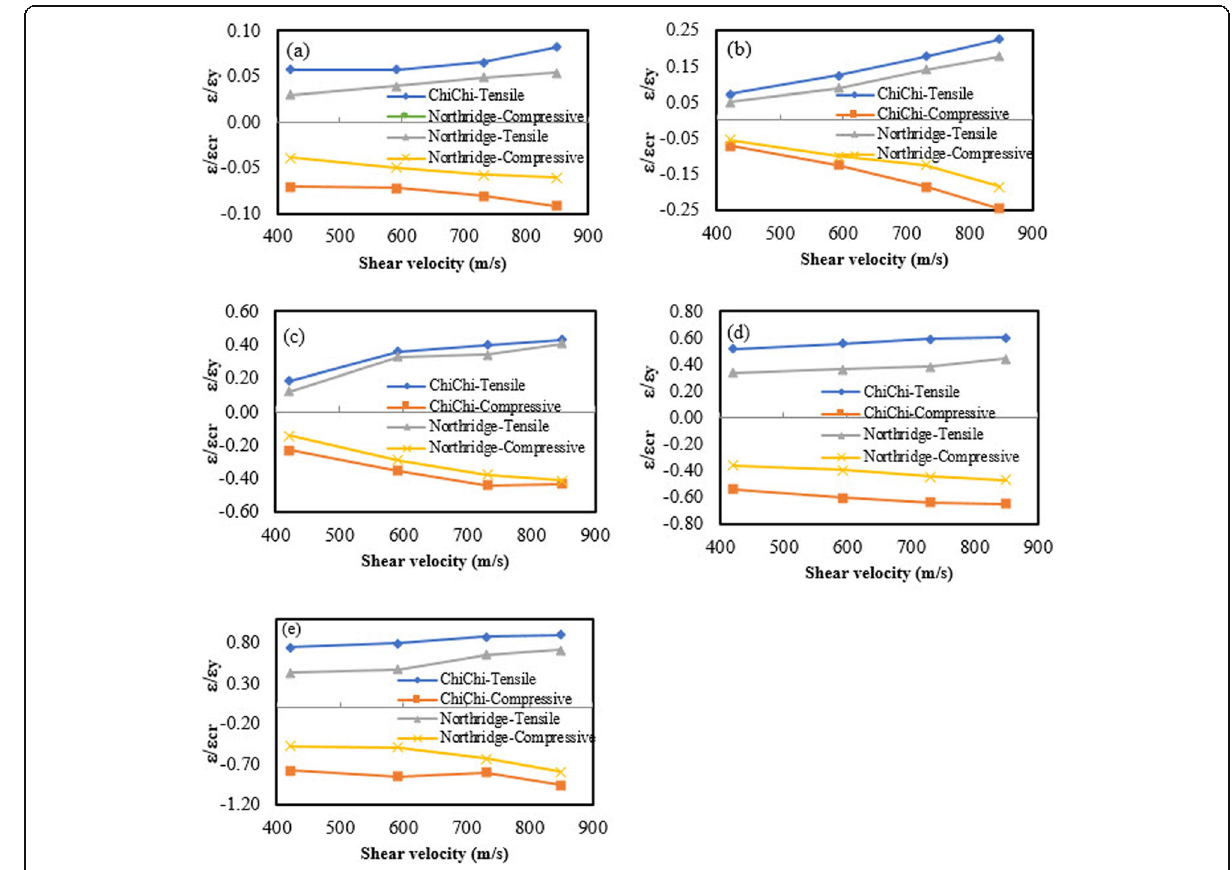
Fig. 11 Effect of material stiffness on strain in pipeline: ( a ) SF = 0.3; ( b ) SF = 0.5; ( c ) SF = 0.7; ( d ) SF = 0.9; ( e ) SF = 1.7